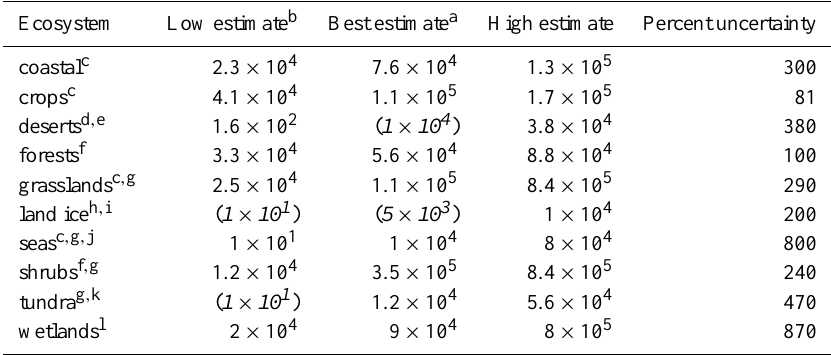
Table 1. Estimates of total mean number concentration of bacteria-containing particles [m − 3 ] in near-surface air of various ecosystem types, reproduced with corrections from Burrows et al.